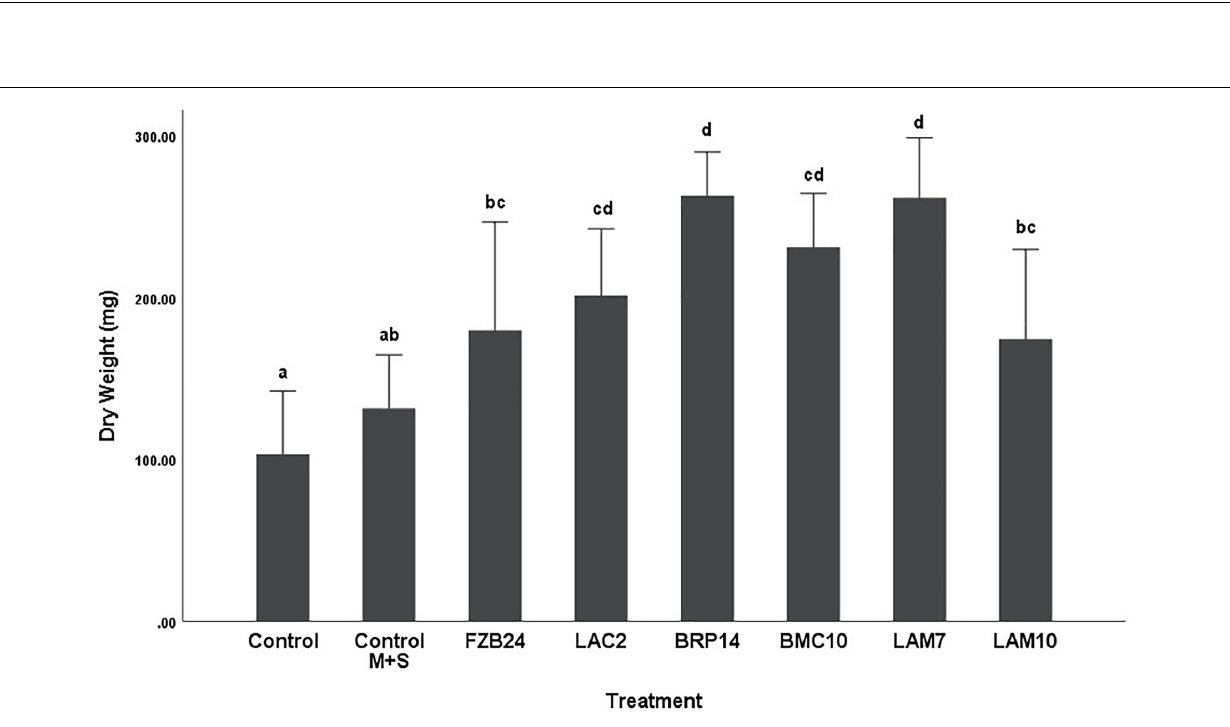
FIGURE 3 | Growth response of plants exposed to BVCs from isolates growing on solid M+S media. Dry weight of plants is measured in (mg), error bars represent confidence interval of the mean 99% ( n = 8). Isolates which share a common letter are not significantly different to one another ( p > 0.01) according to one-way between groups ANOVA with post hoc Tukey